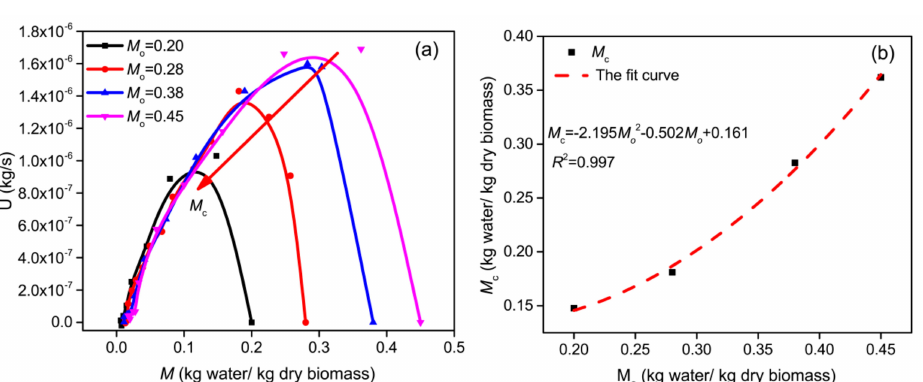
Figure 6. Distribution of critical moisture content for different initial moisture contents: ( a ) drying rate vs. moisture content; ( b ) critical moisture content vs. initial moisture